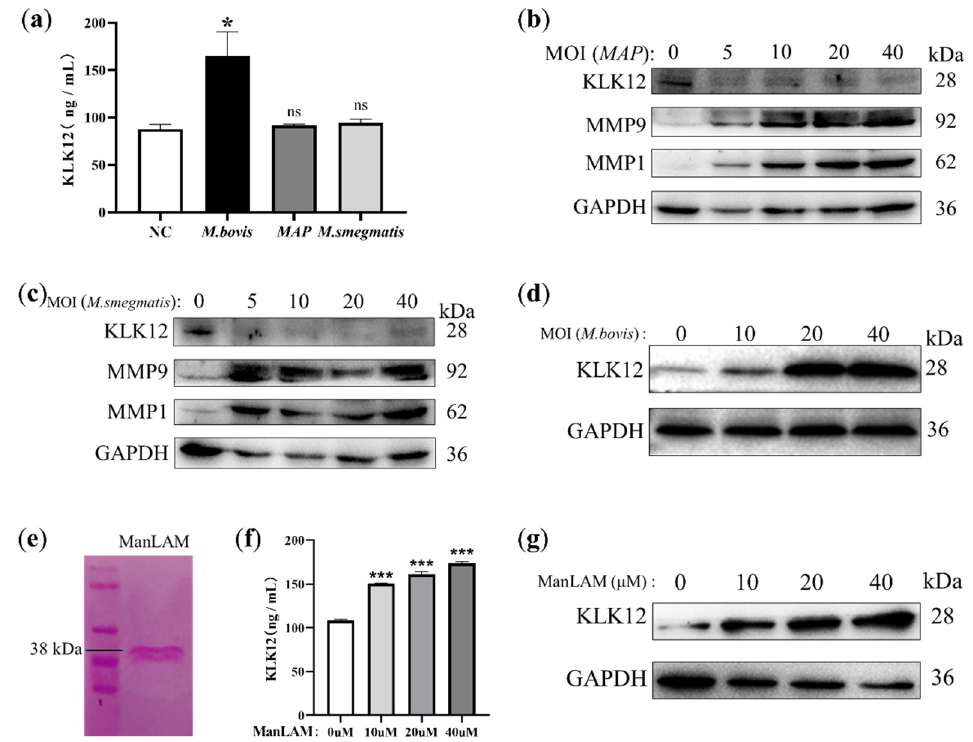
Figure 3. Differences in upregulation of KLK12 secretion and expression by MAP , M. smegmatis , and M. bovis are due to ManLAM. RAW264.7 cells were infected with MAP , M. smegmatis , or M. bovis , and ( a ) KLK12 concentration in cell culture supernatant was measured by ELISA kit 24 h after infection. Western blot analysis to detect KLK12 or MMP-1/-9 expression in cells infected with ( b ) MAP , ( c ) M. smegmatis , and ( d ) M. bovis at various MOIs. ( e ) In this study, ManLAM was extracted from the cell wall of M. bovis and subjected to SDS-PAGE electrophoresis, followed by glycogen PAS staining of the isolated gel. Using various concentrations of ManLAM on RAW264.7 cells, KLK12 was detected in cell culture supernatants and cells using ( f ) ELISA and ( g ) Western blot, respectively. Data represent the mean ± SD of three independent experiments (* p < 0.05; *** p <